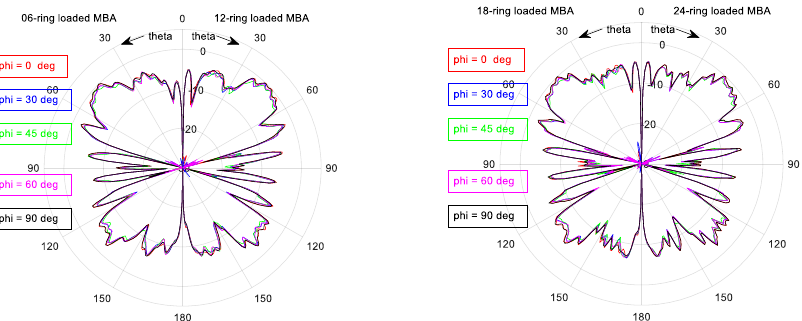
Figure A9. 2D patterns at 52 GHz of 6-, 12-, 18- and 24-ring-loaded MBA in different cutting planes.